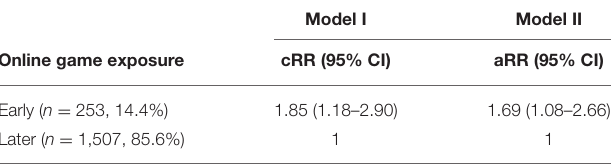
TABLE 3 | Univariable and multivariable GEE analyses using binomial models of the relative risks of incidence of HRIGD in the eighth and/or ninth grades among non-HRIGD adolescents in seventh grade ( n = 1,760/5,280